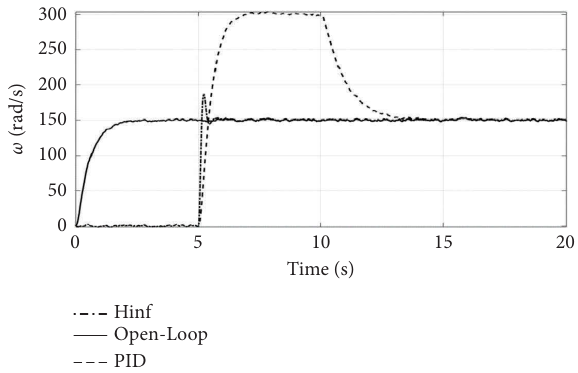
Figure 11: Te angular velocity of the second-order system for τ � 5s and stochastic disturbance.